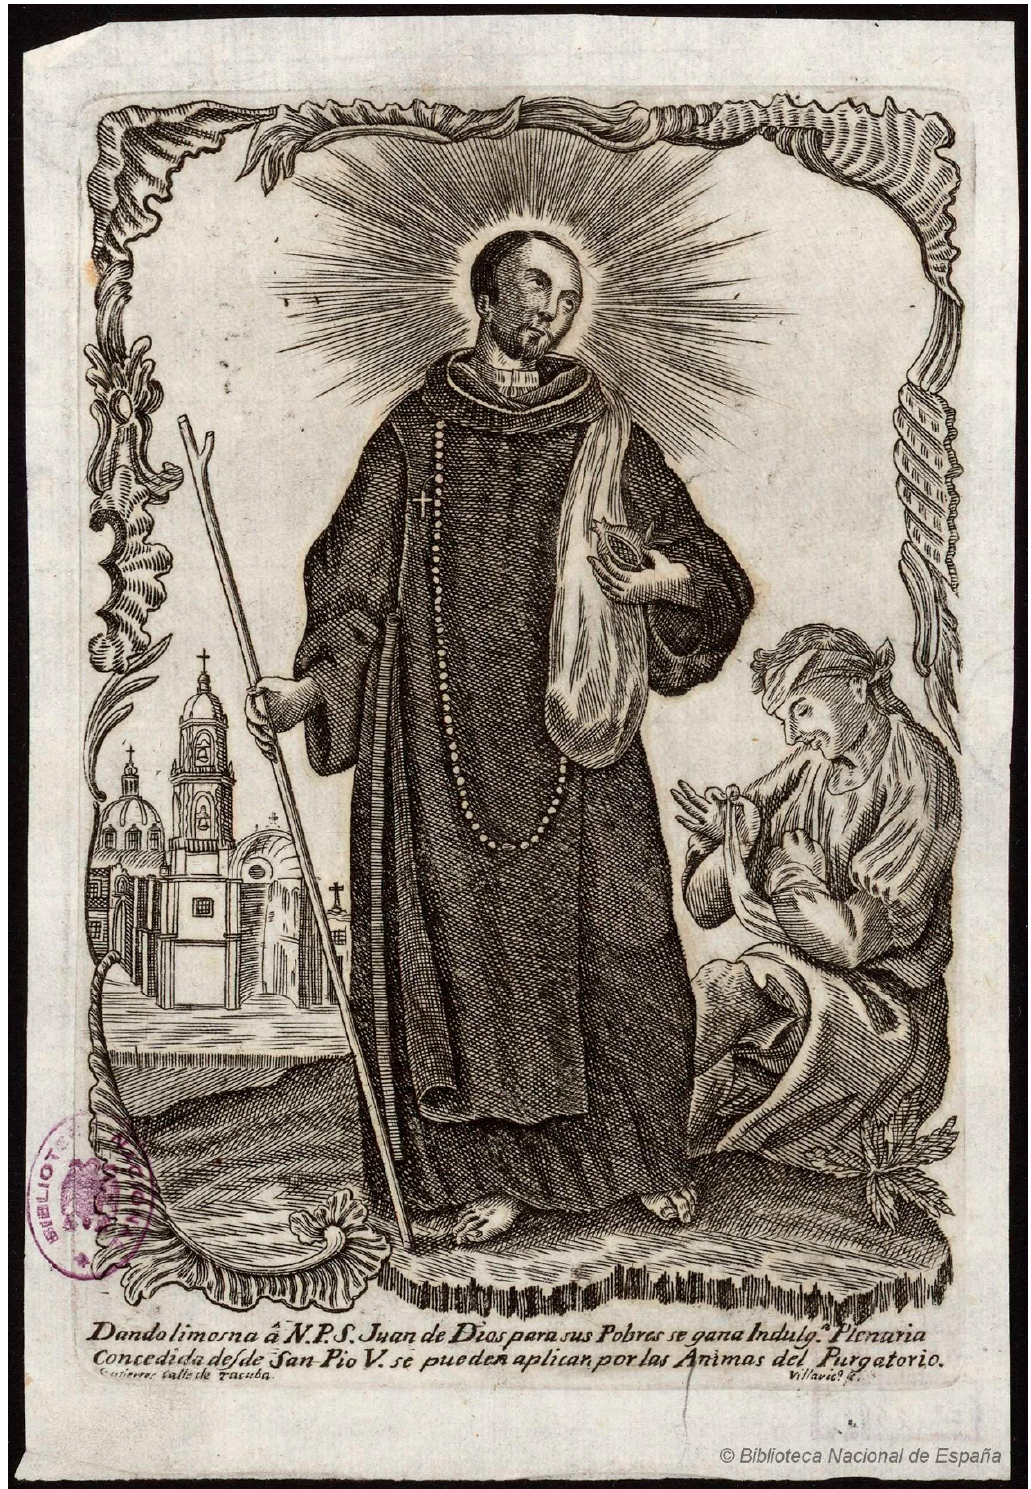
Figure 3. Manuel de Villavicencio, San Juan de Dios , ca. 1770. Engraving. Photograph used with permission of the Biblioteca Nacional de España.